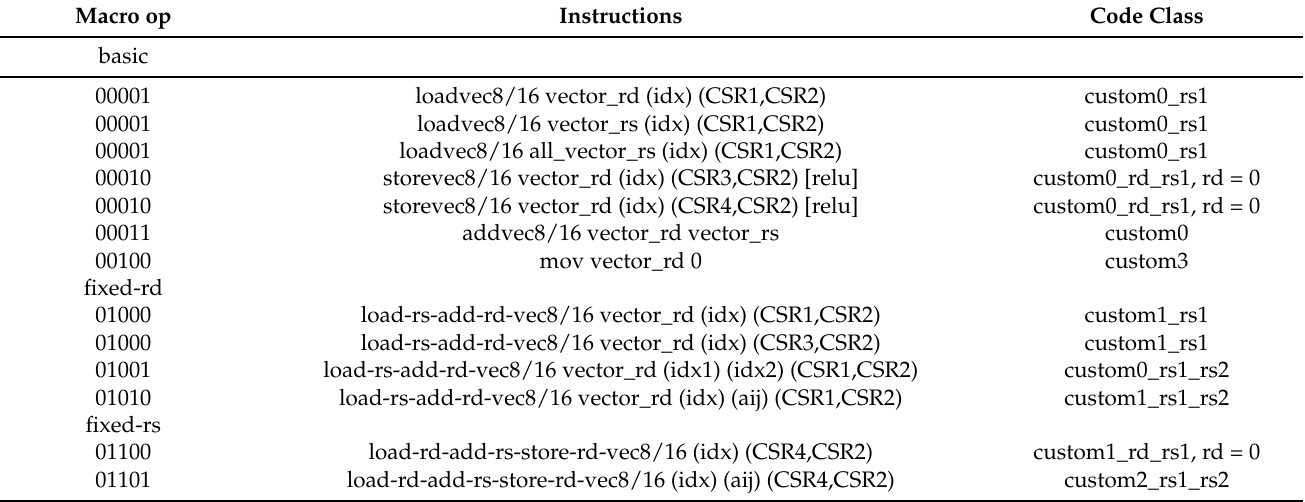
Table 3. The vector instructions